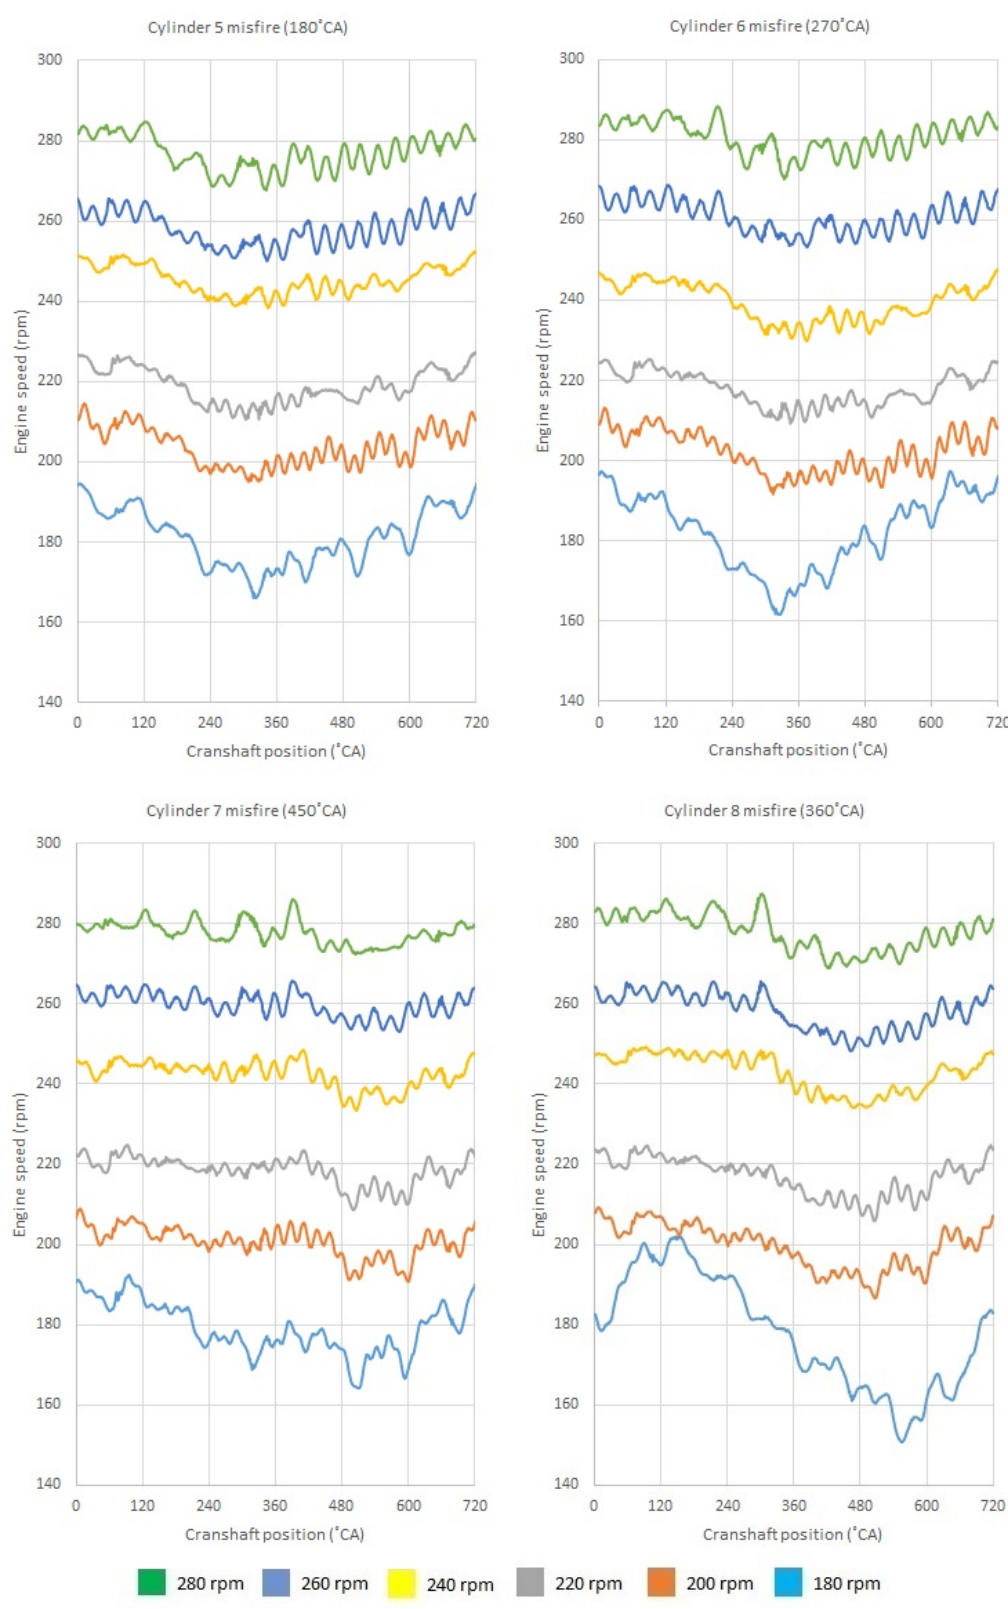
Figure 14. Instantaneous speed ranges at the time of combustion loss in cylinders 5–8 of a Buckau-Wolf R8DV-136 engine for the pre-set speeds of 180–280 rpm.